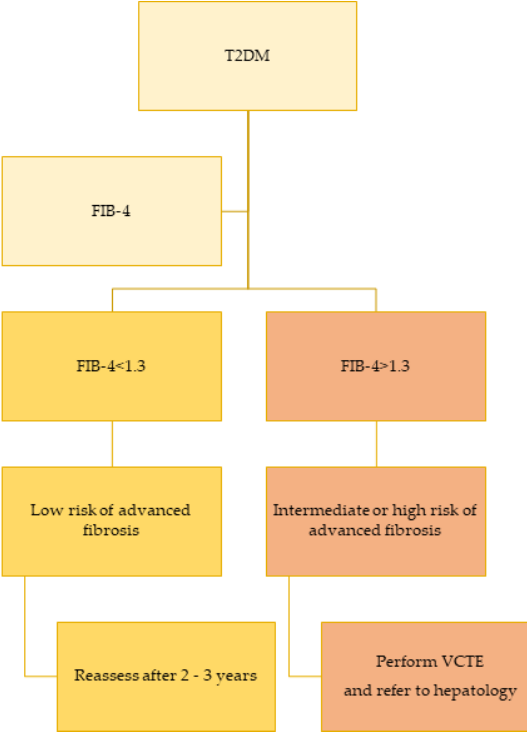
Figure 2. Proposed algorithm to screen patients with type 2 diabetes. Abbreviations : T2DM — type 2 diabetes mellitus; FIB-4 — fibrosis index-4; VCTE — vibration controlled transient elastography.